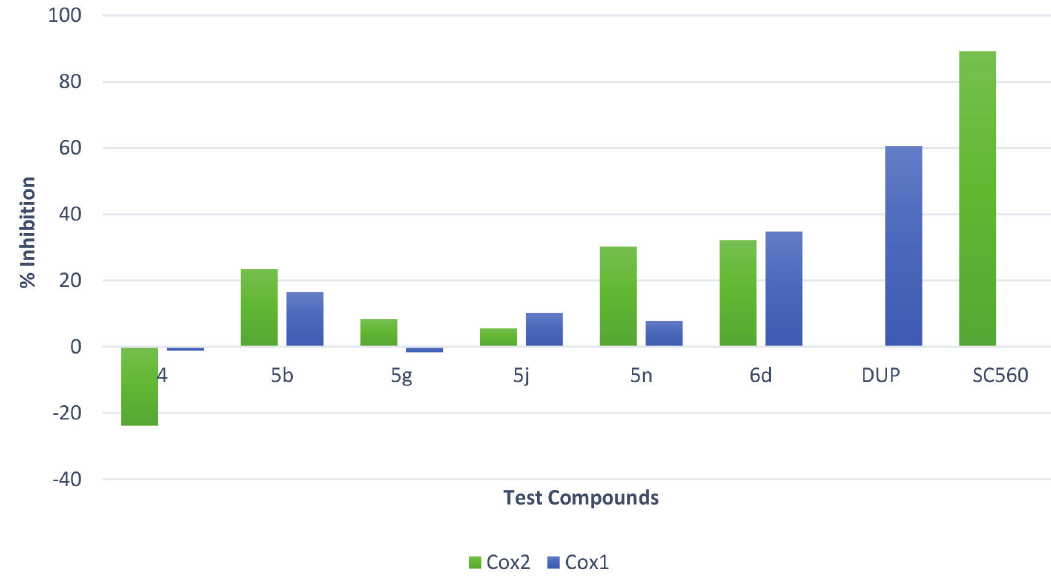
FIGURE 2 - COX-1 and COX-2 Inhibitory activities of test compounds at 10 µM